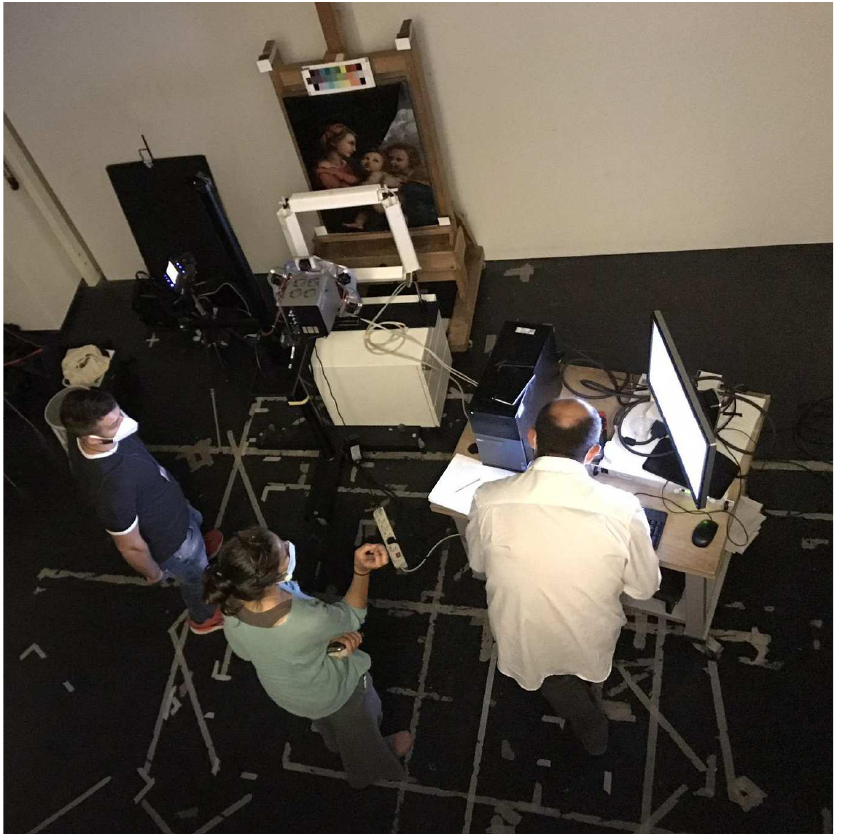
Figure 3. A photograph during PuCT acquisition. The LED system and the thermal camera are placed in front of the inspected painting.